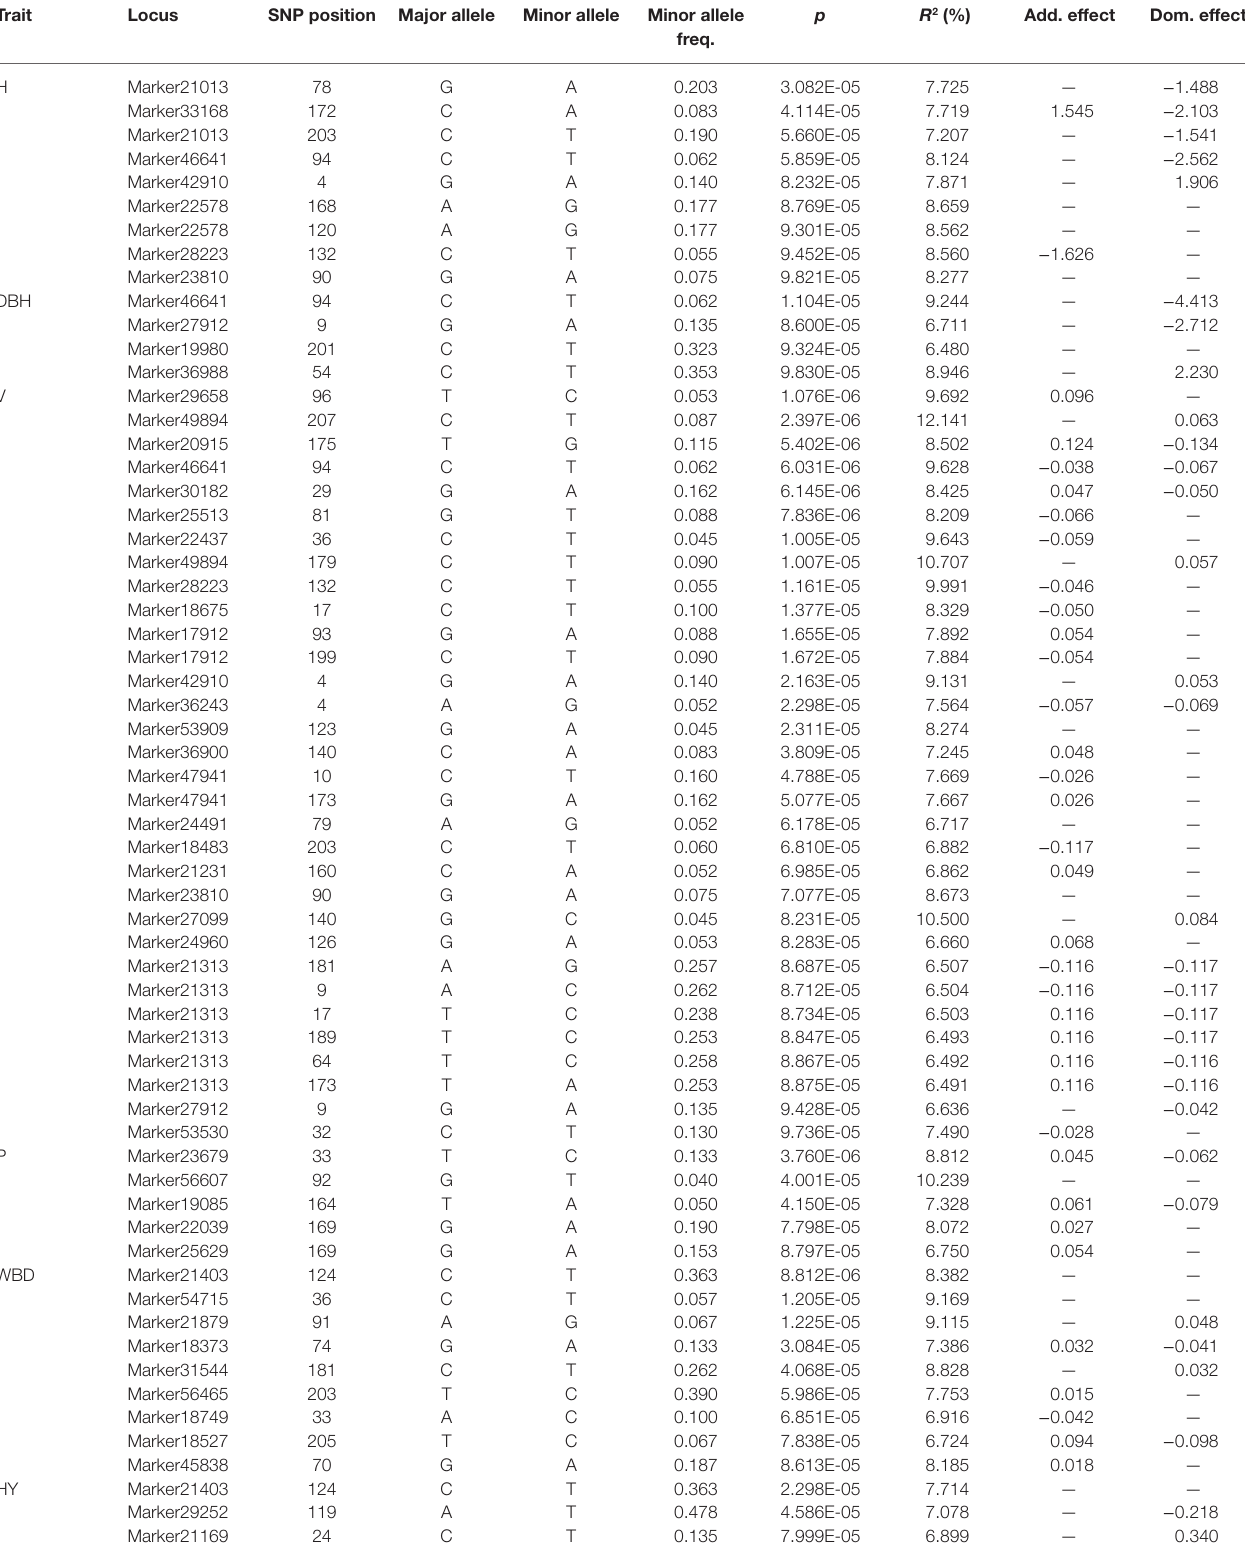
TABLE 3 | SNPs with significant association to growth-related traits based on MLM genome-wide association study (GWAS). Trait Locus SNP position Major allele Minor allele Minor allele